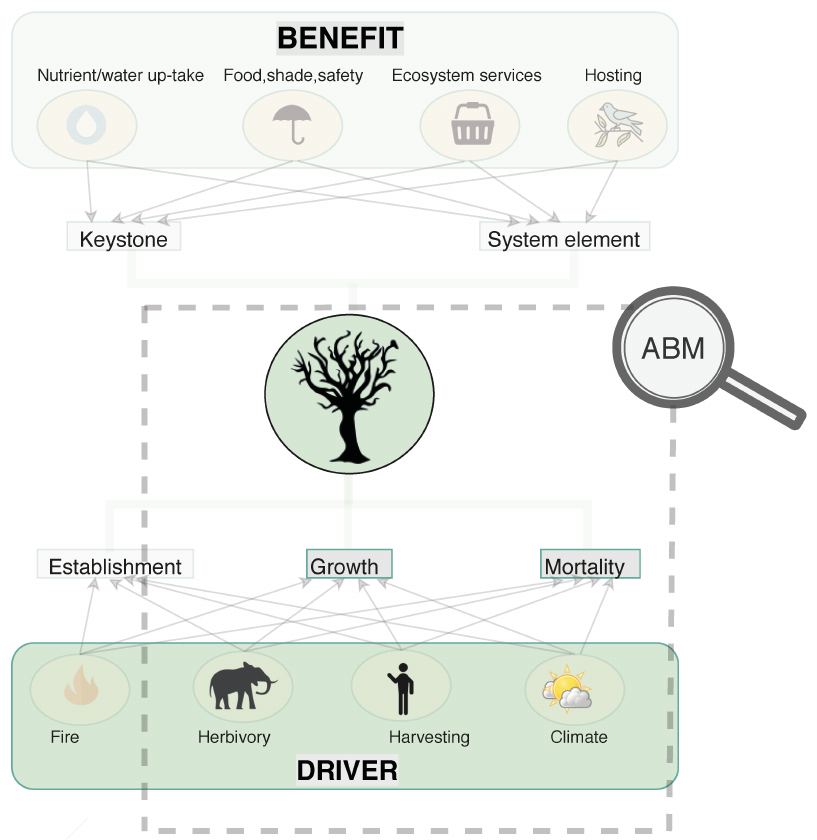
Figure 1. Illustration of trees as keystone species in savannas, offering a set of benefits and being impacted by a set of drivers. The actors within the dashed square are modeled as agent types in the agent-based